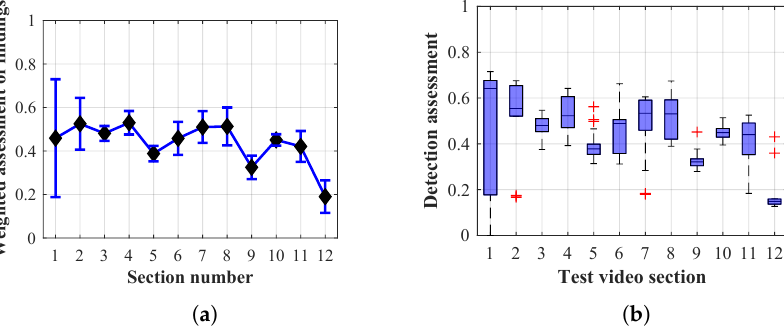
Figure 38. Results of Method 2.1 with a lifespan of 40 frames. ( a ) the weighted average rating with the average mean absolute error of the weighted rating and ( b ) boxplots of the distribution of the statistical sets of the results of the individual sections evaluated indicating: minimum, 1st quartile, median, 3rd quartile, maximum.